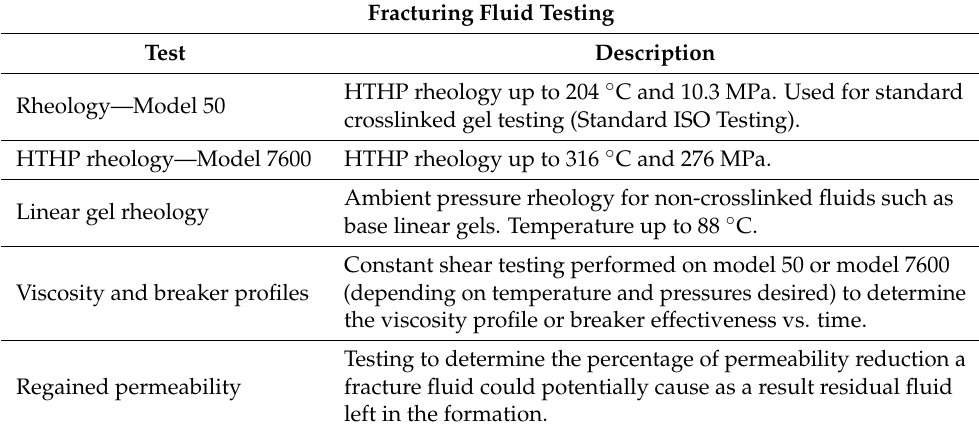
Table 1. Fracturing fluid